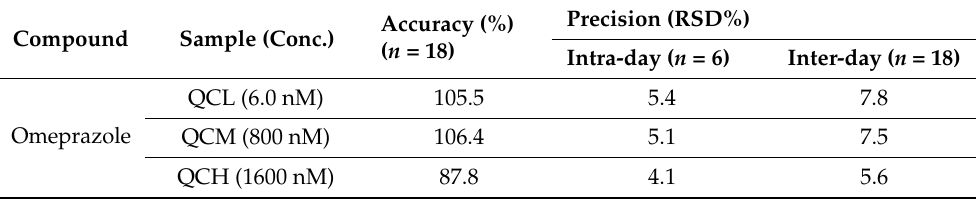
Table 1. Precision of quality control (QC) samples of omeprazole (OME) in human saliva. Compound Sample